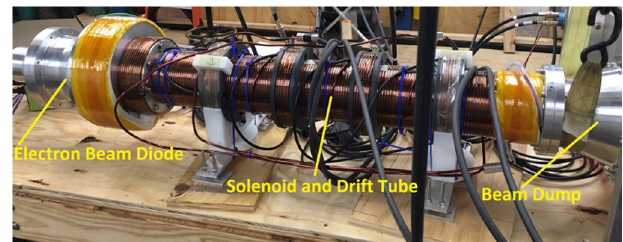
FIG. 4. Photo of the electron beam diode, solenoid-wrapped drift tube, and beam